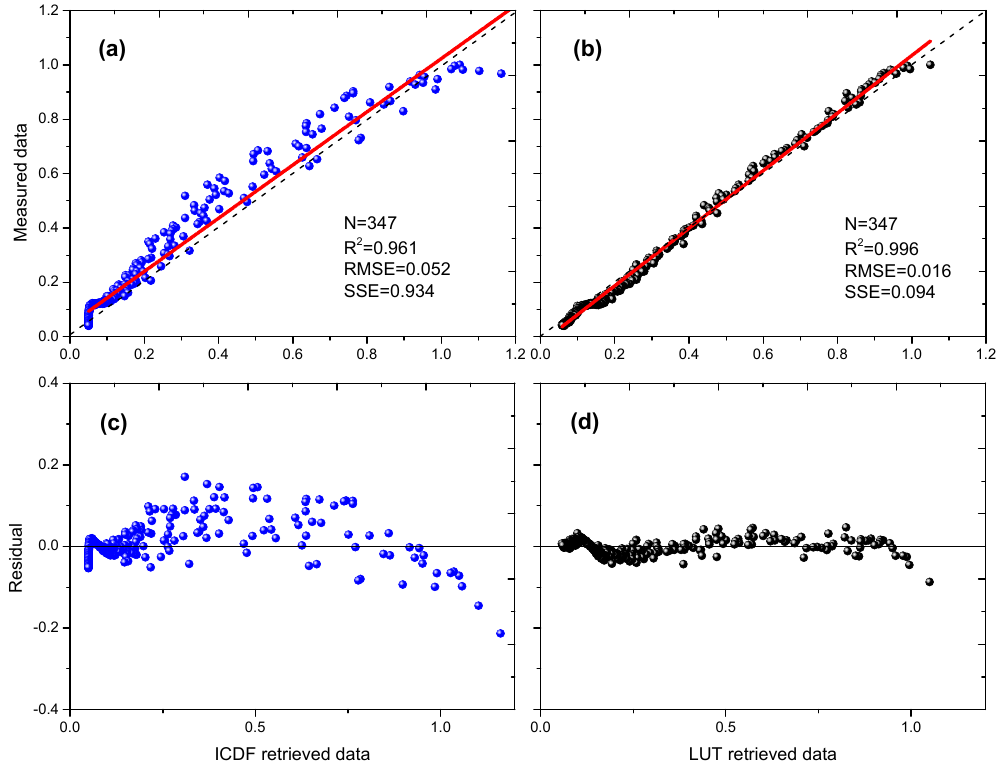
Figure 7. Regression plots of simulated-signal vs. airborne lidar measured-signal. ( a ) Regression plot of inverse cdf (ICDF) retrieved data vs. measured data, ( b ) regression plot of LUT retrieved data vs. measured data, ( c ) residual plot of ICDF retrieved data vs. measured data, ( d ) residual plot of LUT retrieved data vs. measured data.